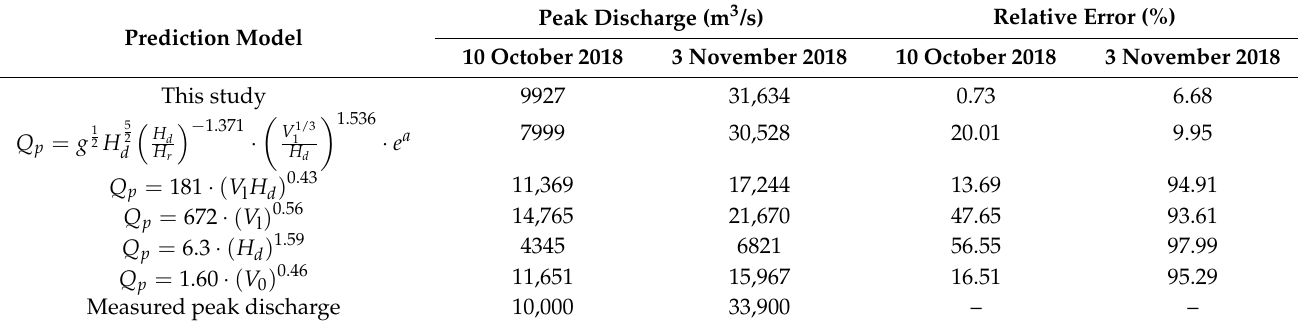
Table 5. Simulated results of peak discharge of two dam breaks in Baige of Jinsha River in 2018. Prediction